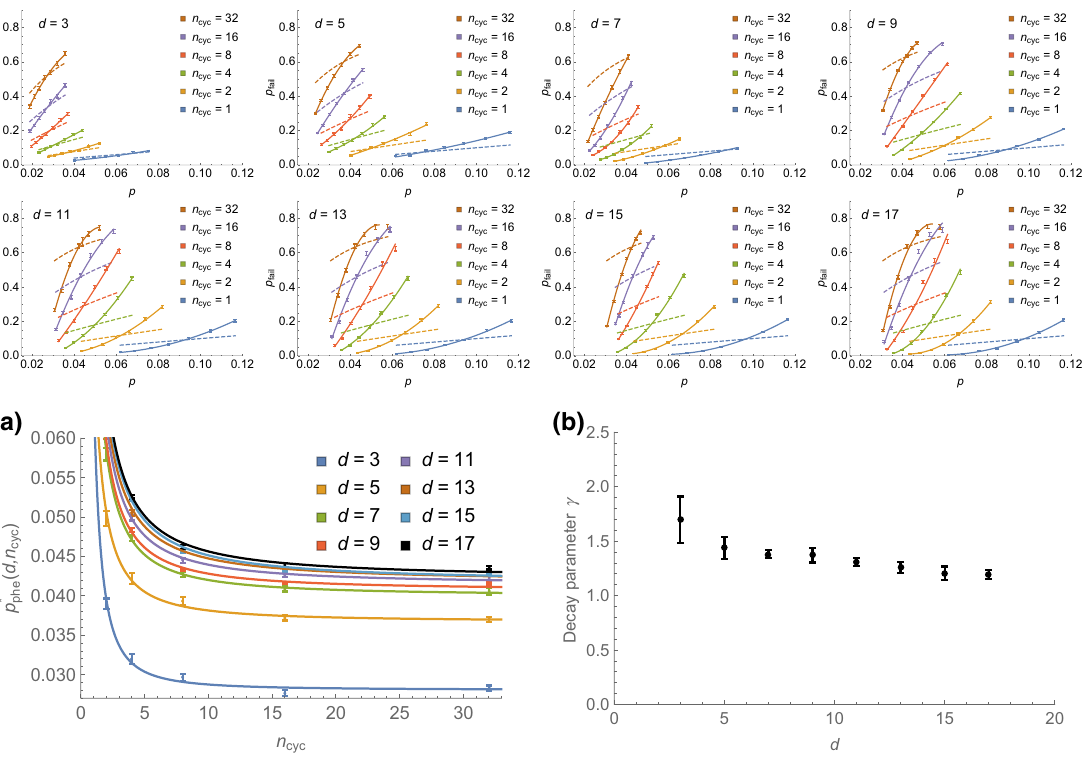
FIG. 33. (Top two rows) Failure probability of n cyc QEC cycles for phenomenological noise of strength p given a perfect initial ( d , n ) as an intersection of state and final QEC cycle, for various distances d . We estimate the time-dependent pseudothreshold p ∗ cyc phe quadratic fits (solid lines) with the corresponding physical qubit error probability p phy ( n cyc ) as defined in Eq. (5) in the main text (dashed ∗ ( d , n ) as a function of n ( d ) curves). (a) The time-dependent pseudothreshold p ∗ cyc cyc . We estimate the long-time pseudothresholds p phe phe ( d , n ) with the ansatz in Eq. (11) in the main text and in (b) we plot the decay parameter γ . We observe that γ stabilizes by fitting p ∗ cyc phe rapidly with increasing d , confirming that the residual noise reaches equilibrium over a time that is independent of system